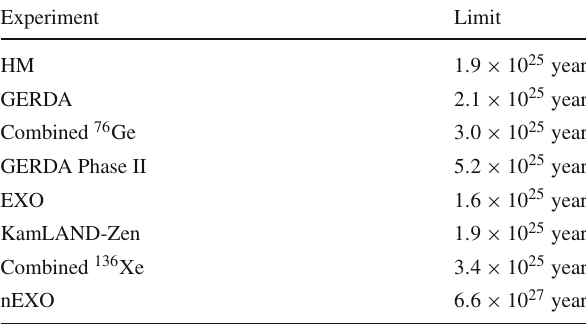
Table 5 Limits on the half-life of 0 νββ